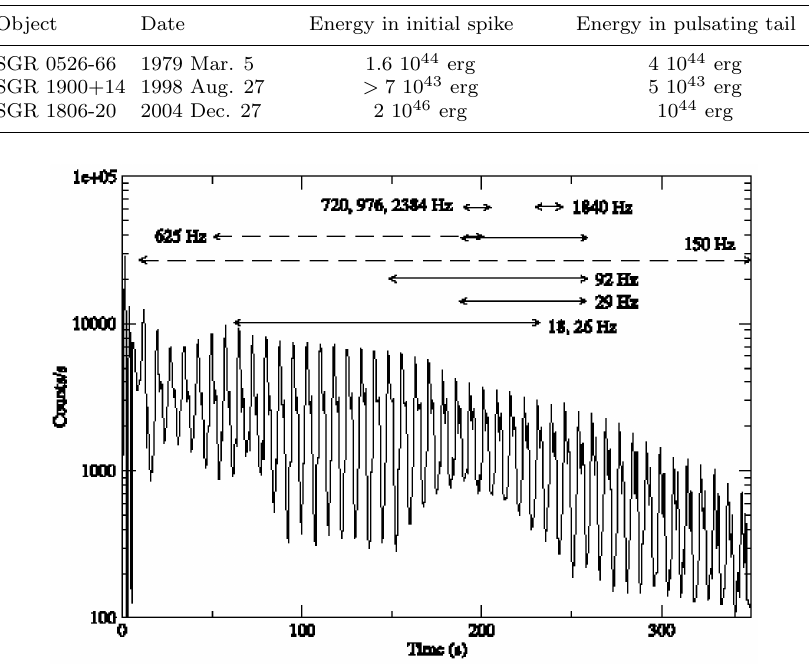
Fig. 1. Time periods when the various fast QPOs from 18 to 2384 Hz were detectable by RXTE and RHESSI in ‘ringing tail’ of SGR 1806-20. The spin period is 7.56 s (Strohmayer & Watts